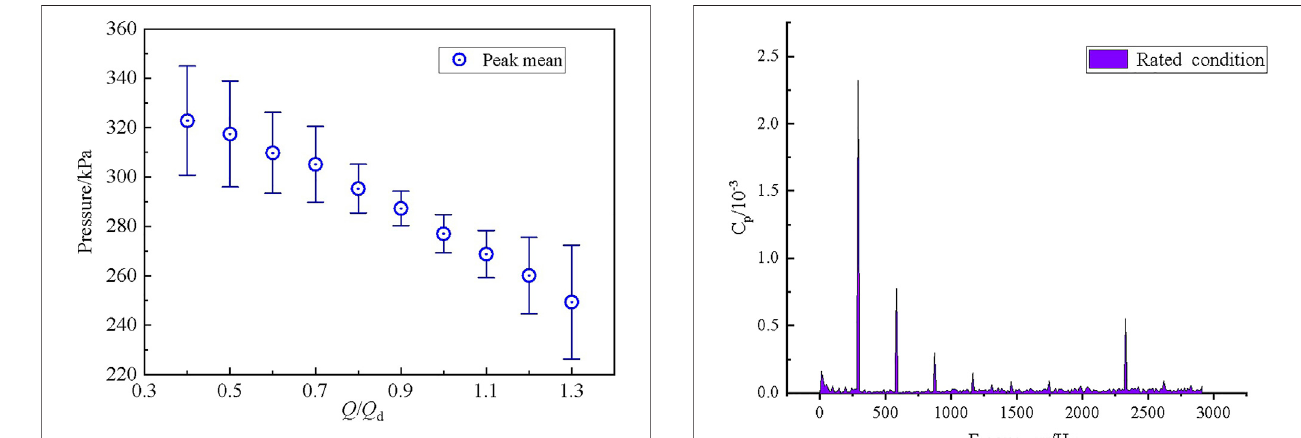
FIGURE 10 | Peak difference diagram of pressure pulsation.